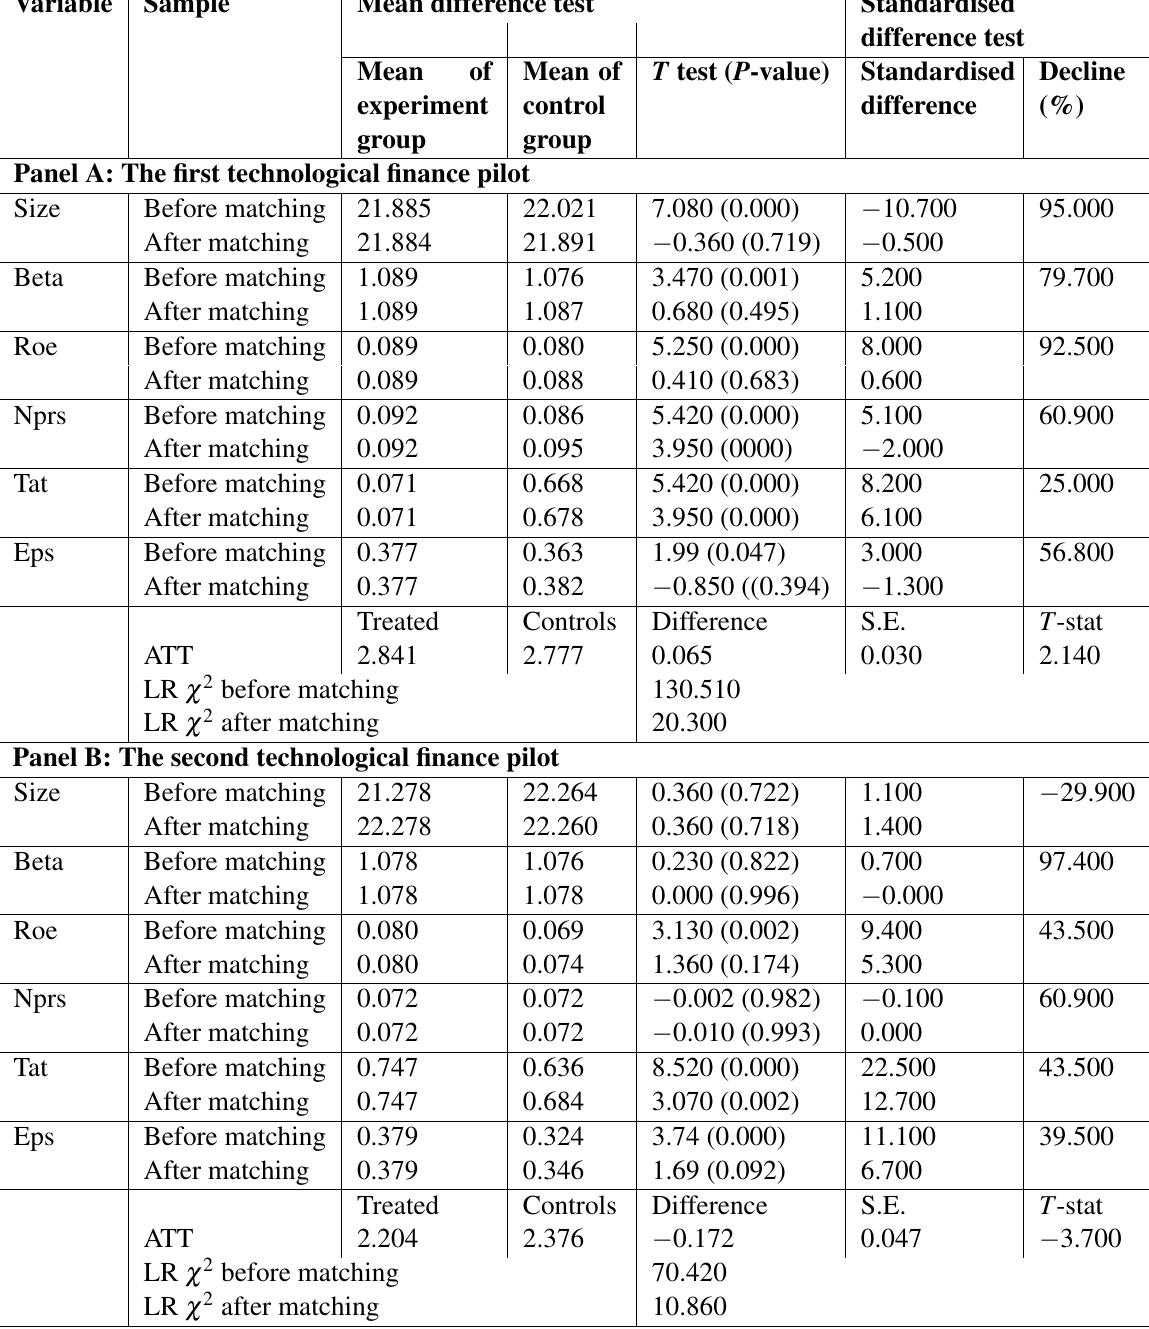
Table 5 The balance test results of the PSM of two technological finance